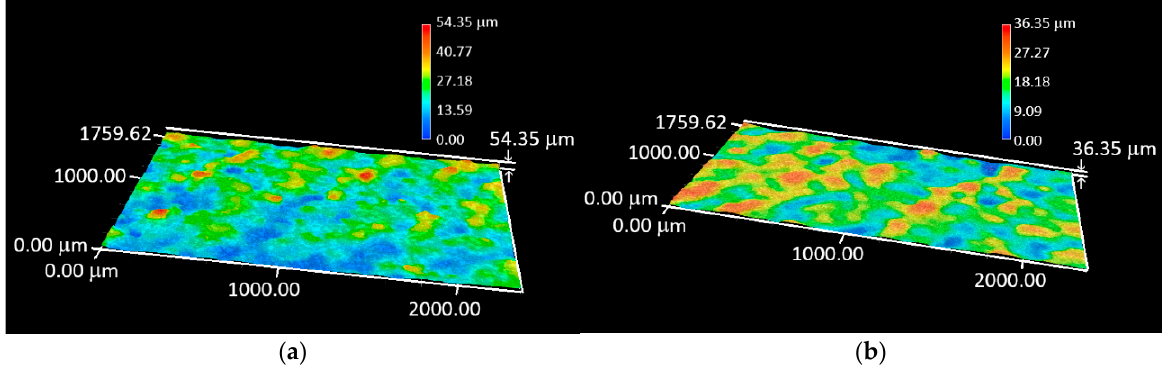
Figure 7. Surface profile of ( a ) Sample 5 and ( b ) Sample 6.